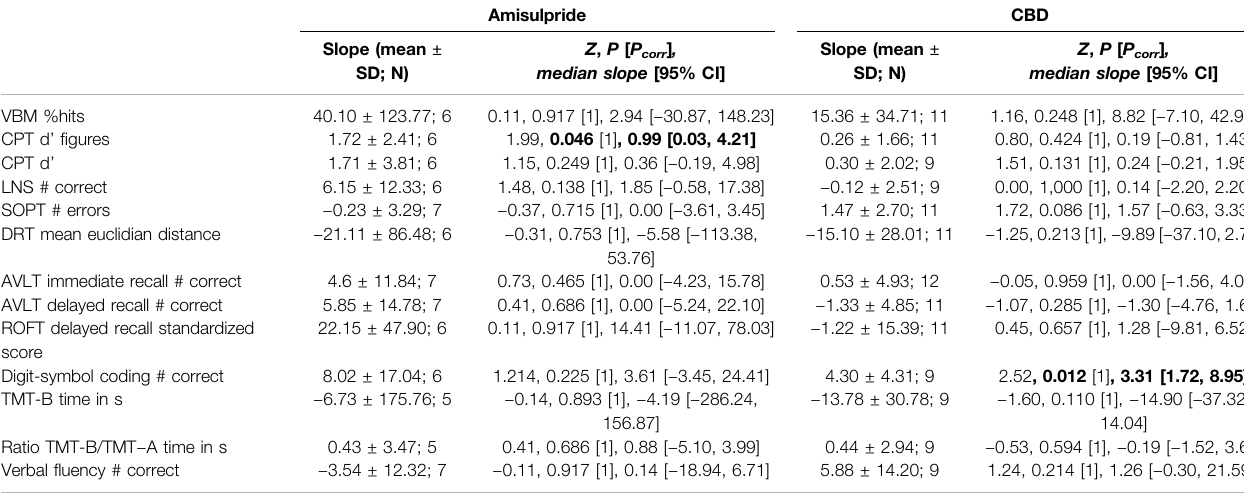
TABLE 4 | Association of change in serum anandamide levels and change in neurocognitive performance. Wilcoxon signed-rank test of the null hypothesis that the distribution of slopes is symmetric about zero. Statistical signi fi cant changes (p ≤ 0.05) are indicated in bold.